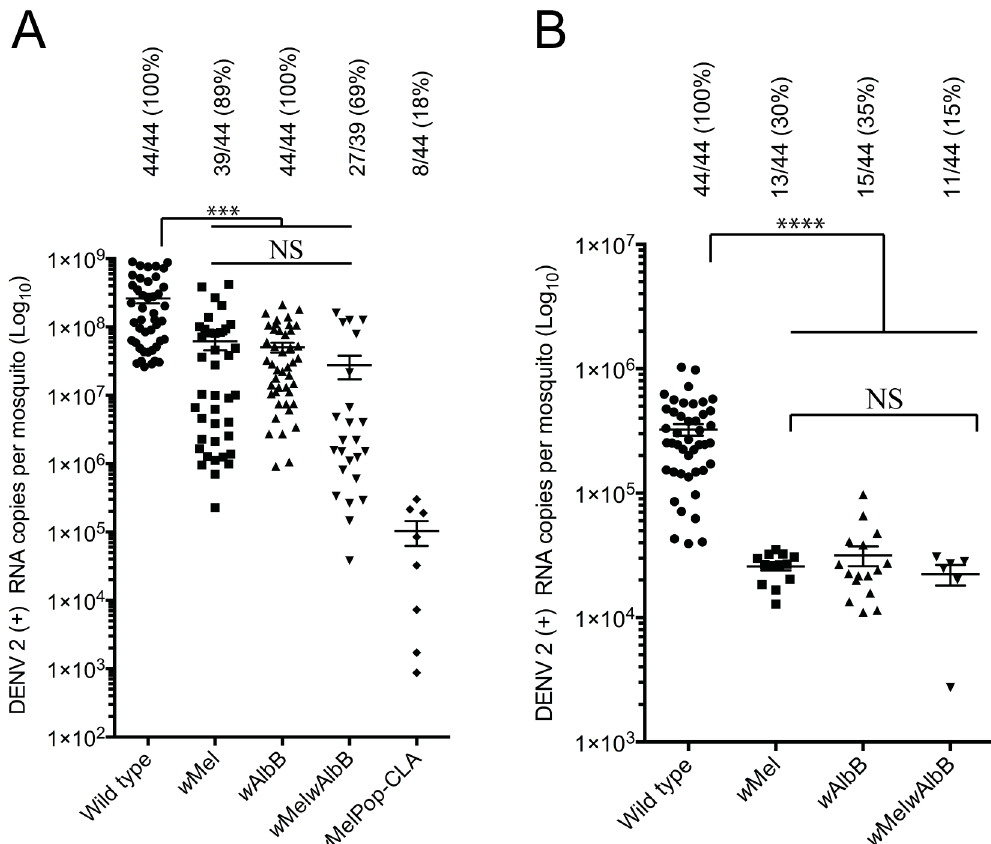
Fig 4. DENV serotype 2 (ET300) genome copies in Wolbachia -infected and wild type mosquitoes. (A) DENV-2 was injected at 10 4 genome copies per ml into the thorax of 3 – 5 day old female mosquitoes. Virus replication was quantified 7 days post injection in whole mosquito bodies using qPCR. For each mosquito line the mean number of genome copies is plotted and standard error of the mean is indicated. Infection rates are indicated as percentages. (B) DENV-2 was administered in a blood meal at 10 7 copies per ml. Virus replication was quantified in whole mosquito bodies 14 days post feeding. For each mosquito line the mean number of genome copies is plotted and standard error of the mean is indicated. For both A and B significant differences between wild type and Wolbachia infected mosquitoes are indicated by *** (p < 0.0001 and infection rates are indicated as percentages). Zero values were not plotted or included in determining the mean or standard error of the